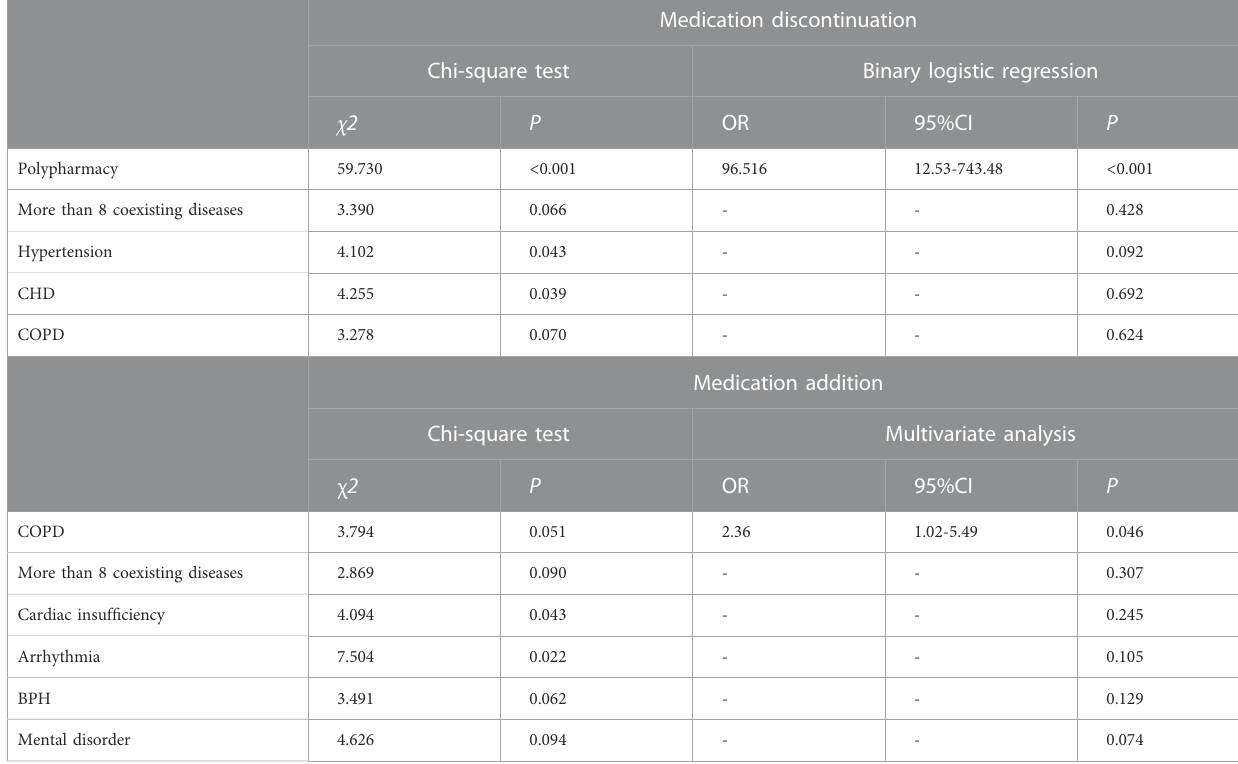
TABLE 4 Factors associated with the discontinuation or addition of medication at